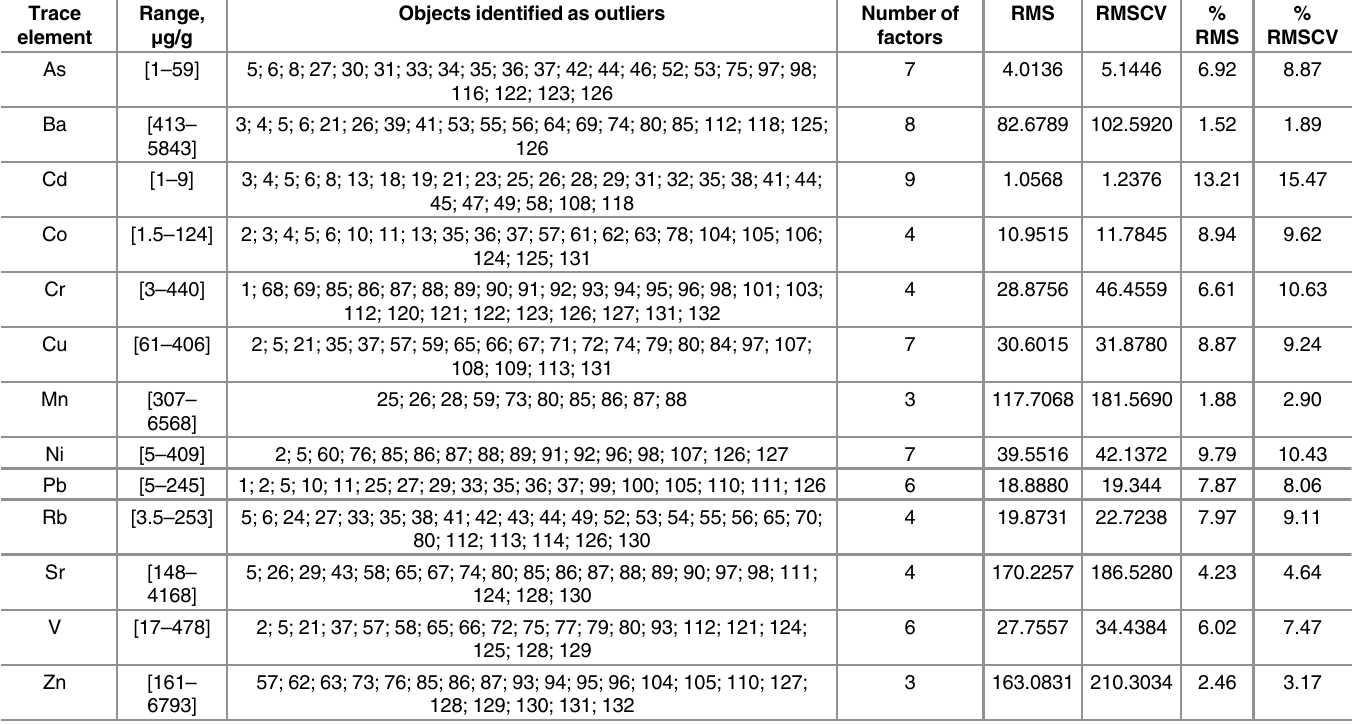
Table 3. The RMS and RMSCV errors of the final PLS